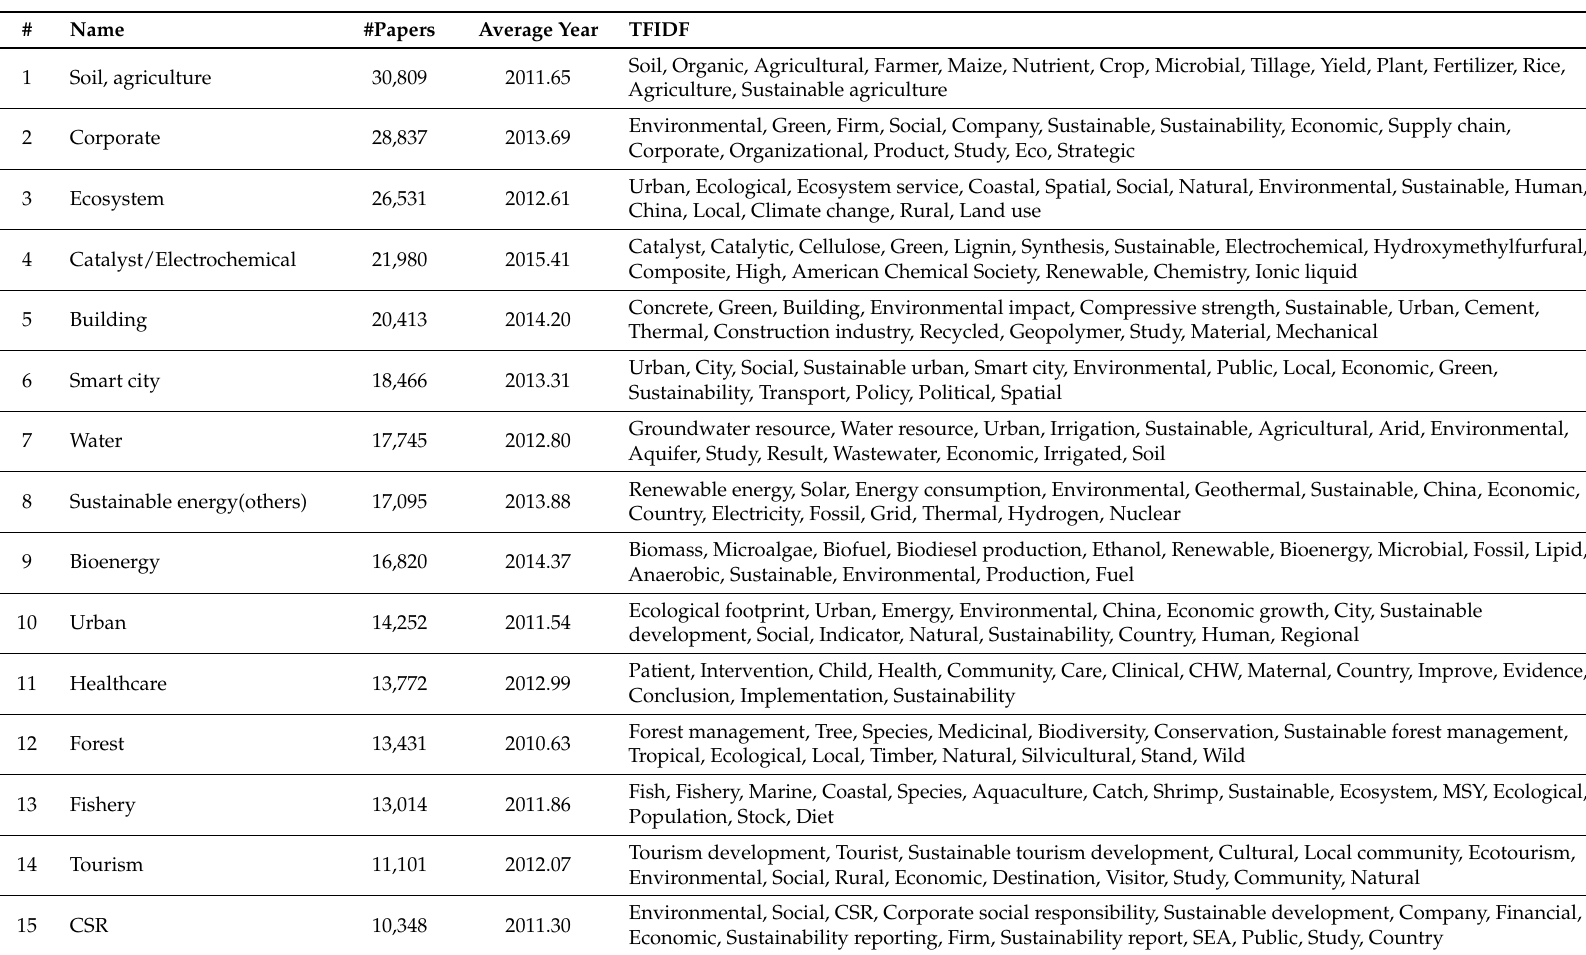
Table 1. Details of retrieved academic